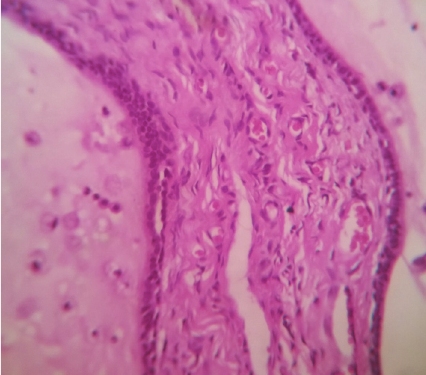
Figure3:Cysticlumenlinedbycuboidal/columnarcellswithlumen containing mucin and